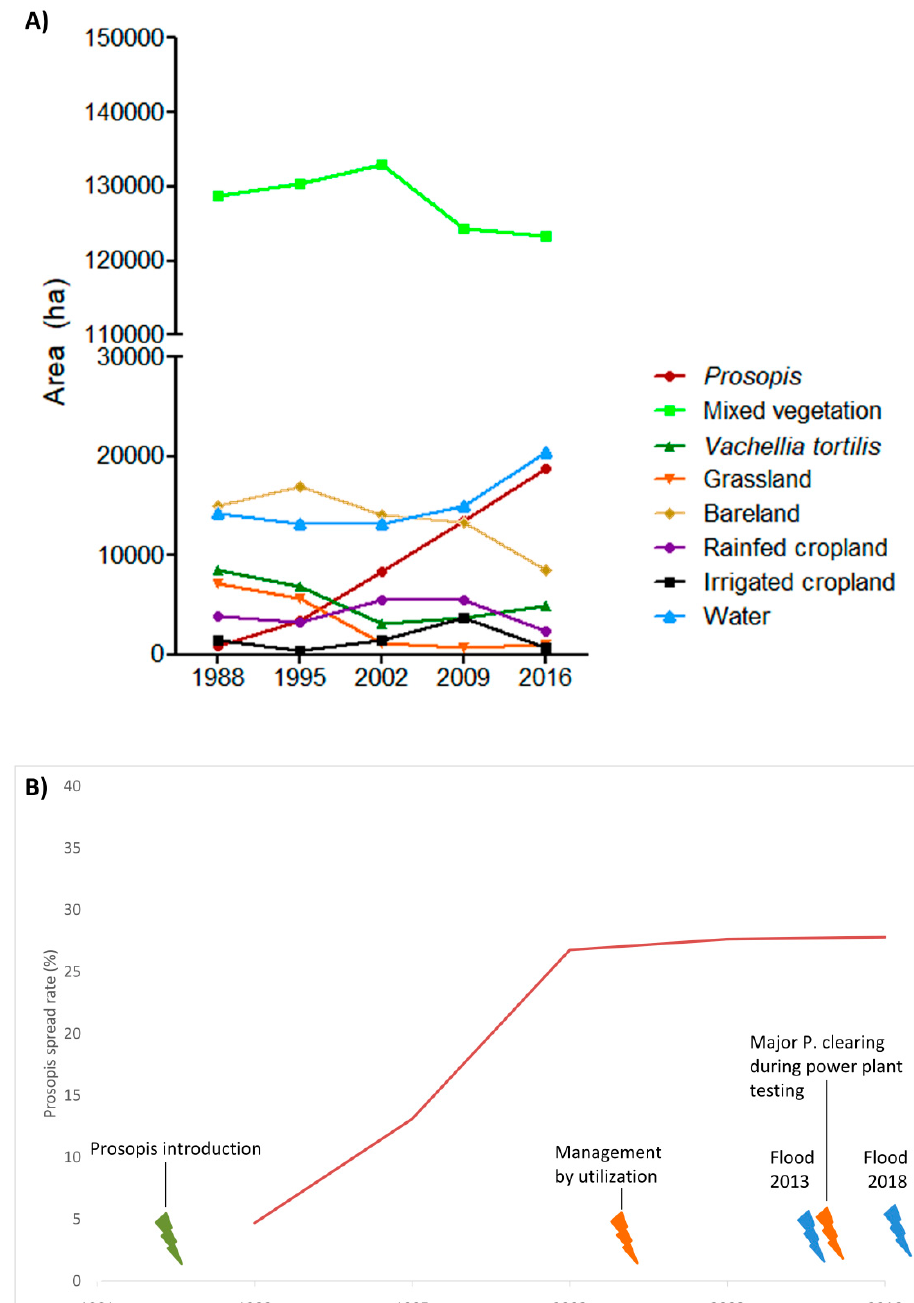
Figure 3. ( a ) LULC trends in hectares for each class from 1988 to 2016. ( b ) Invasion spread rate for each observed seven-year time interval (not per year) from Prosopis introduction until 2016 (with the totally invaded area in 2016 considered as 100%).